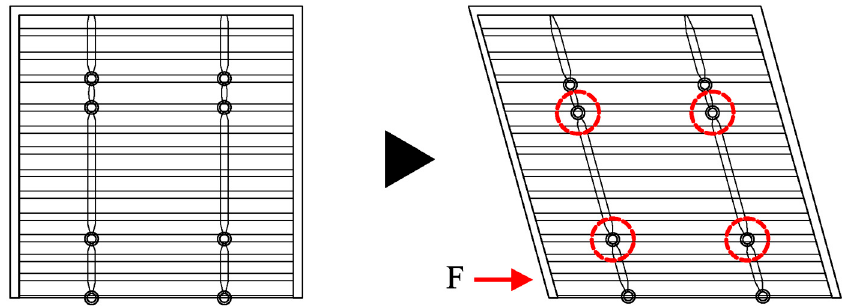
Figure 4. Horizontal deformation of masonry walls and Dieh-Dou frames.